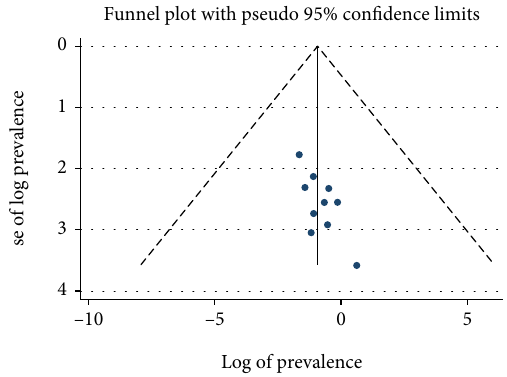
Figure 3: Funnel plot with 95% con fi dence limit of the pooled prevalence of Implanon discontinuation in Ethiopia,